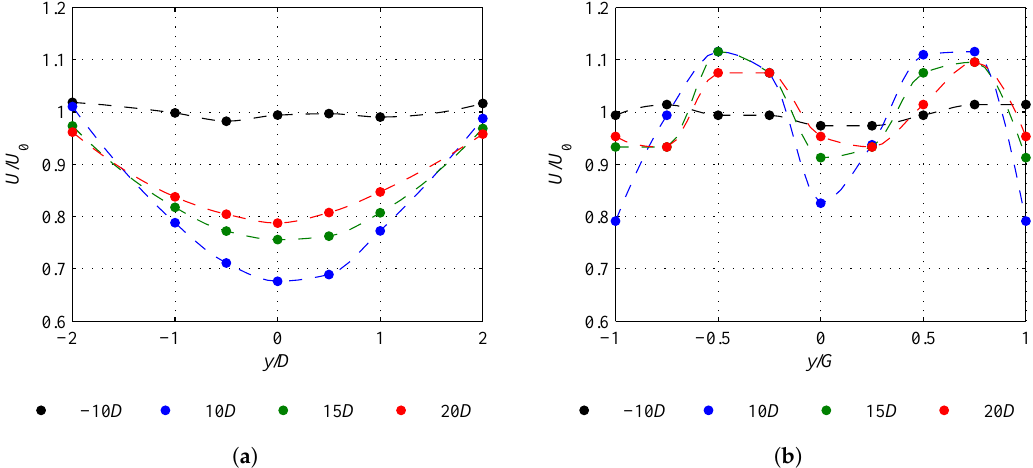
Figure 7. Transverse velocity profiles of mean flow velocity for the ( a ) cylinder and ( b ) vane array collision geometries at Re = 2.1 × 10 4 . The velocity profiles were measured at mid-depth ( z = 0) across four stream-wise locations in the flume; one upstream of the collision geometry ( x = − 10 D ), and three downstream ( x = 10 D ,15 D ,20 D ).